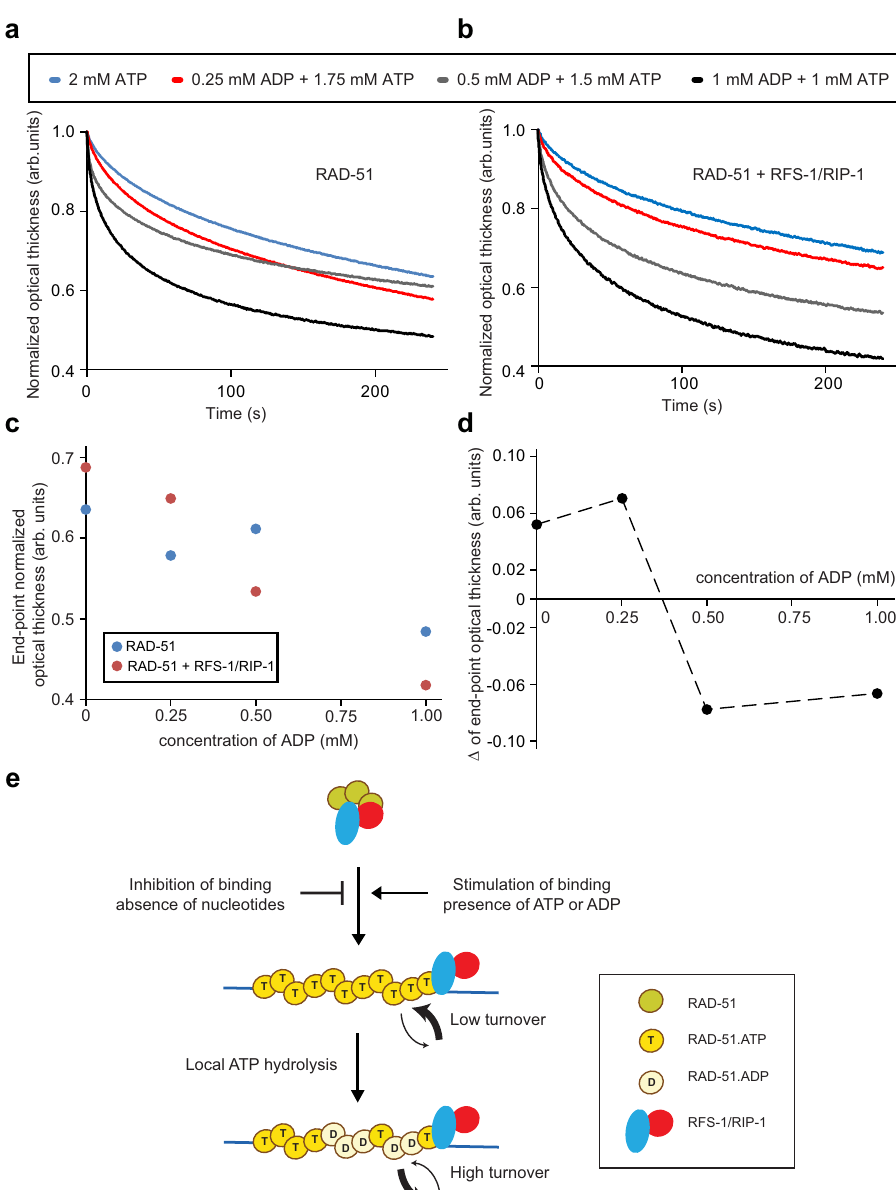
Fig. 5 A threshold of ADP in the RAD-51-ssDNA fi lament triggers a switch in RFS-1/RIP-1 activity from stabilization to destabilization. a , b Normalized dissociation phases obtained from BLI experiments using 3 ′ biotinylated ssDNA (15 nM) where RAD-51 (1 μ M) alone ( a ) or in the presence of RFS-1/RIP-1 (0.25 μ M) ( b ) was loaded on the biosensor together with different ATP/ADP ratios. The biosensor with bound proteins was then submerged in buffer without any nucleotide cofactor and 1000-fold excess of unlabelled ssDNA to facilitate dissociation. c The corresponding endpoint in optical thickness across the dissociation phase for the data presented in ( a and b ) is plotted as a function of ADP concentration. d The difference in the values in ( c ) for RAD-51 ±RFS-1/RIP-1 was plotted to estimate the break point where stabilization switches to destabilization. e Schematic model of the action of RAD51 paralogs based on our results. RAD-51 binding to ssDNA is inhibited by RAD51 paralogs in the absence of nucleotides, whereas in ATP or ADP the formation of nucleo fi laments is stimulated. Filaments undergoing local ATP hydrolysis are destabilized leading to RFS-1/RIP-1-mediated fi lament turnover. Source data are provided as a Source Data fi